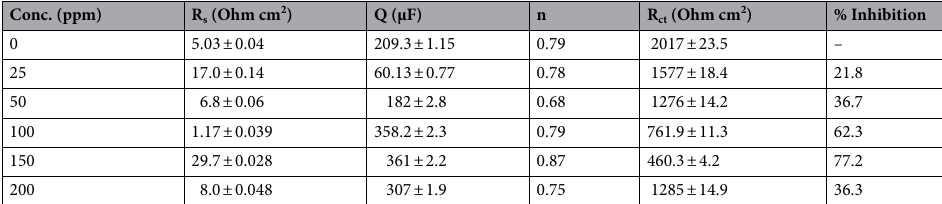
Table 2. Computer fit results (± error) of the impedance spectra obtained for the steel electrode that was cathodically polarized in CaCl 2 brine solution containing different concentrations of copolymer 2 after 3